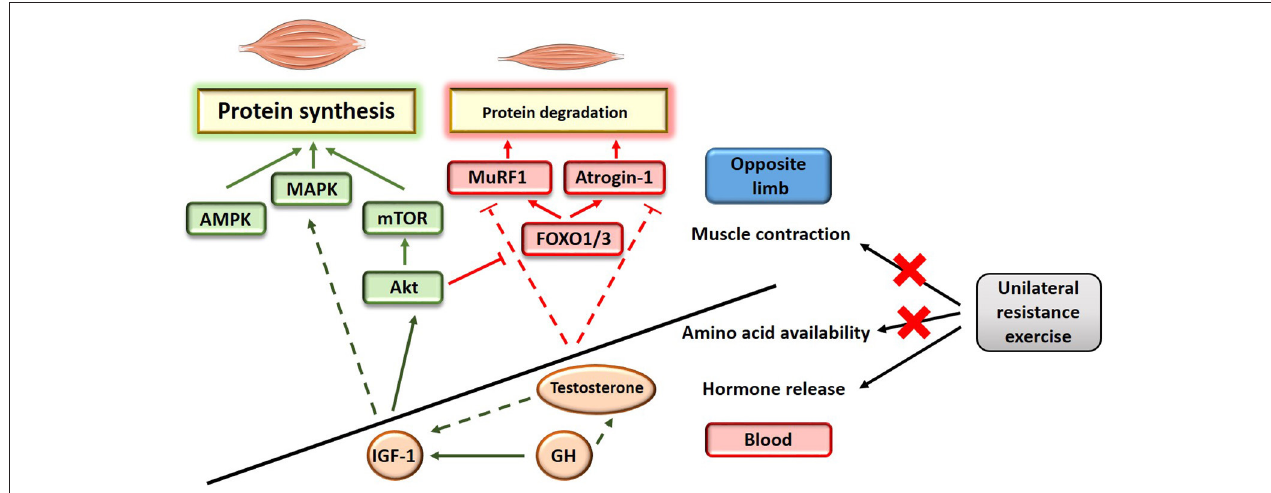
FIGURE 1 | Schematic illustration of the potential mechanisms influencing muscle protein balance as a result of unilateral training. Full line indicates a direct effect; dashed line indicates an indirect effect.